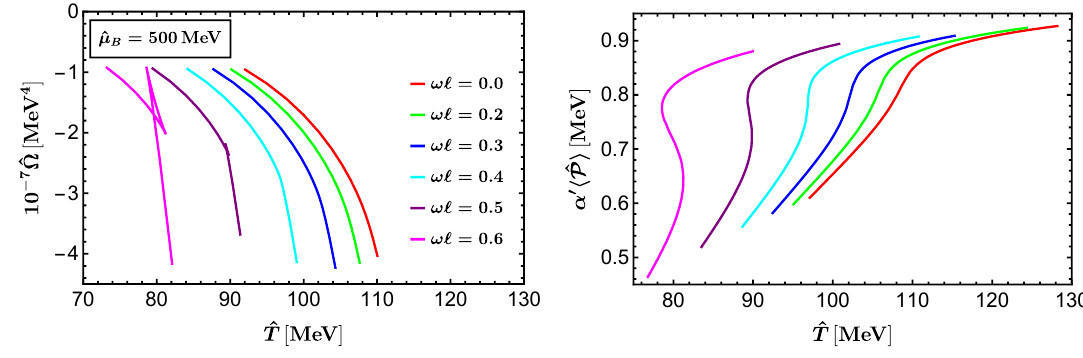
Figure 4 . The free energy ˆΩ (left) and the Polyakov loop at different ω for ˆ µ B = 500 MeV. The phase transition becomes first-order when ω‘ > 0 . 44